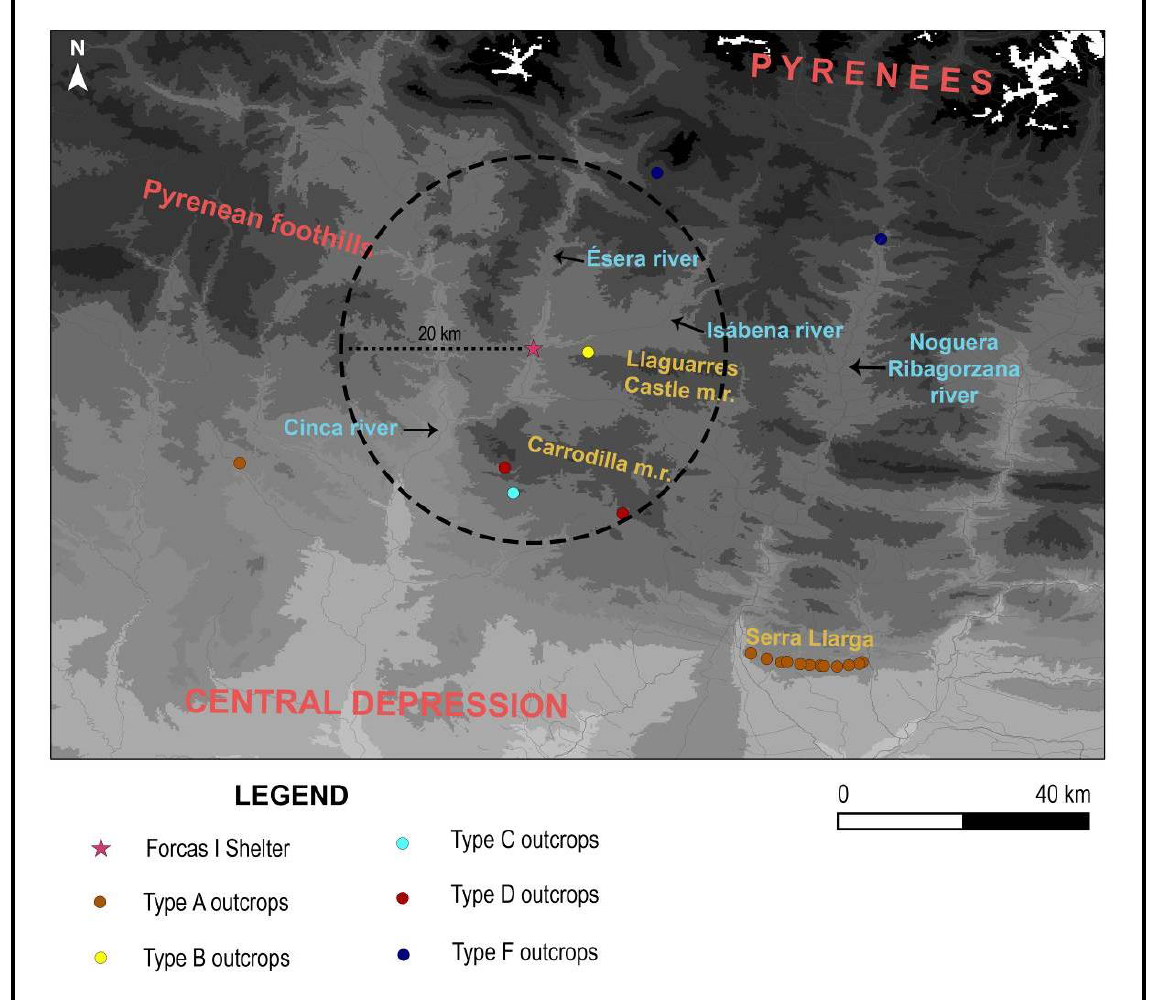
Figure 7. Forcas I Shelter and the different geological formations with parallels in the archaeological